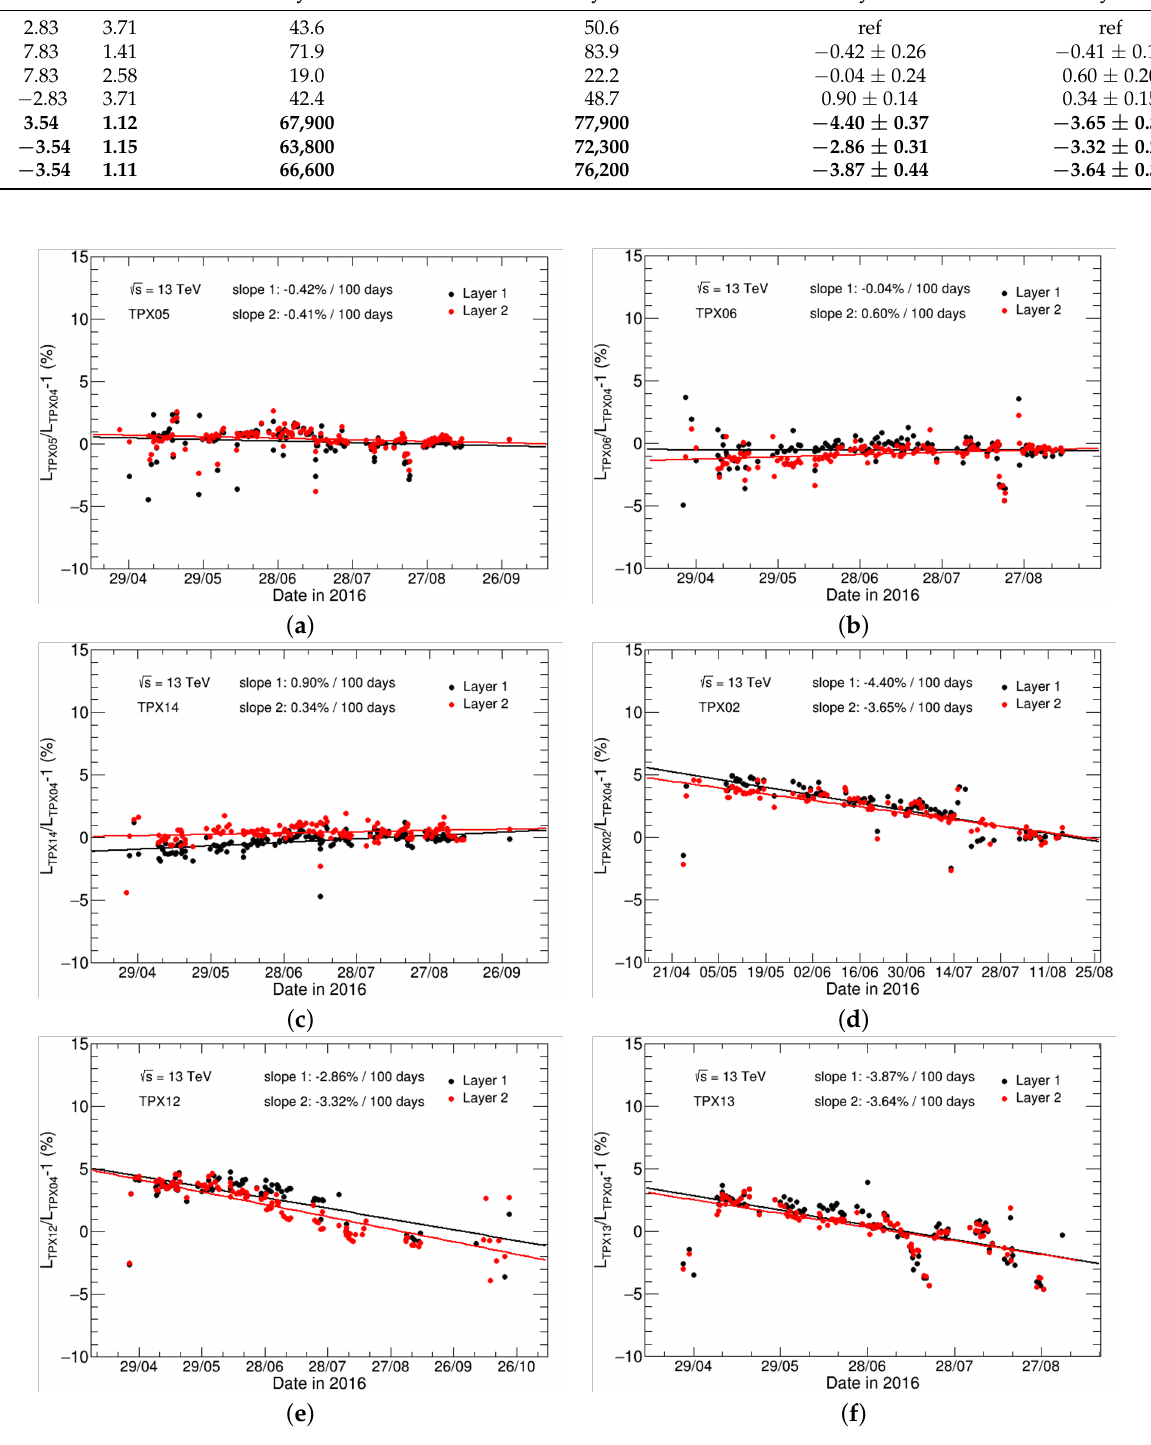
Figure 52. Low-rate devices: ( a ) Luminosity ratio of devices TPX05 and TPX04 for each LHC fill. ( b ) Luminosity ratio of devices TPX06 and TPX04 for each LHC fill. ( c ) Luminosity ratio of devices TPX14 and TPX04 for each LHC fill. High-rate devices: ( d ) Luminosity ratio of devices TPX02 and TPX04 for each LHC fill. ( e ) Luminosity ratio of devices TPX12 and TPX04 for each LHC fill. ( f ) Luminosity ratio of devices TPX13 and TPX04 for each LHC fill. Taken from Ref.